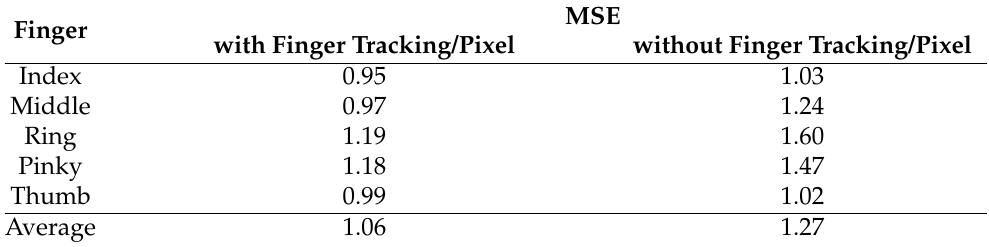
Table 2. Mean-Squared Error (MSE) of finger positions estimated by CNN w/ and w/o finger tracking. MSE Finger with Finger Tracking/Pixel without Finger Tracking/Pixel Index 0.95 1.03 Middle 0.97 1.24 Ring 1.19 1.60 Pinky 1.18 1.47 Thumb 0.99 1.02 Average 1.06